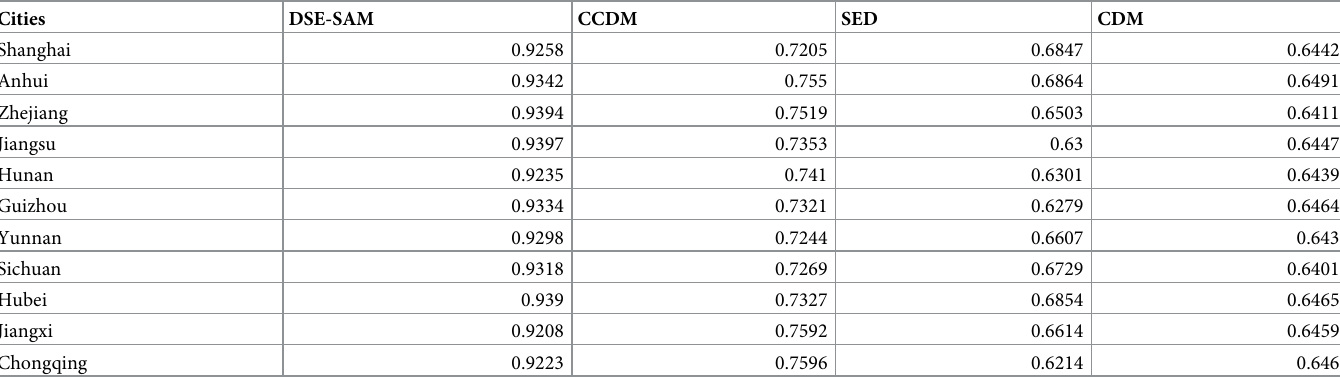
Table 6. Correlation analysis of various economic